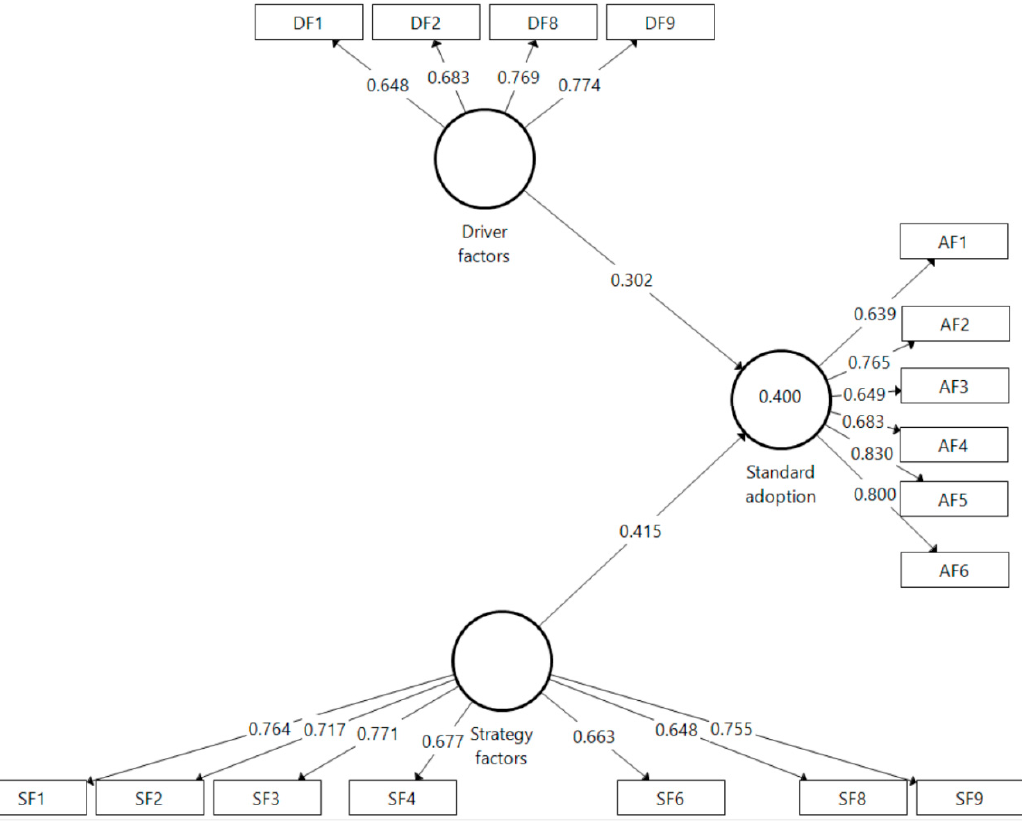
Figure 4. Convergent validity of measurement model (R 2 and factor